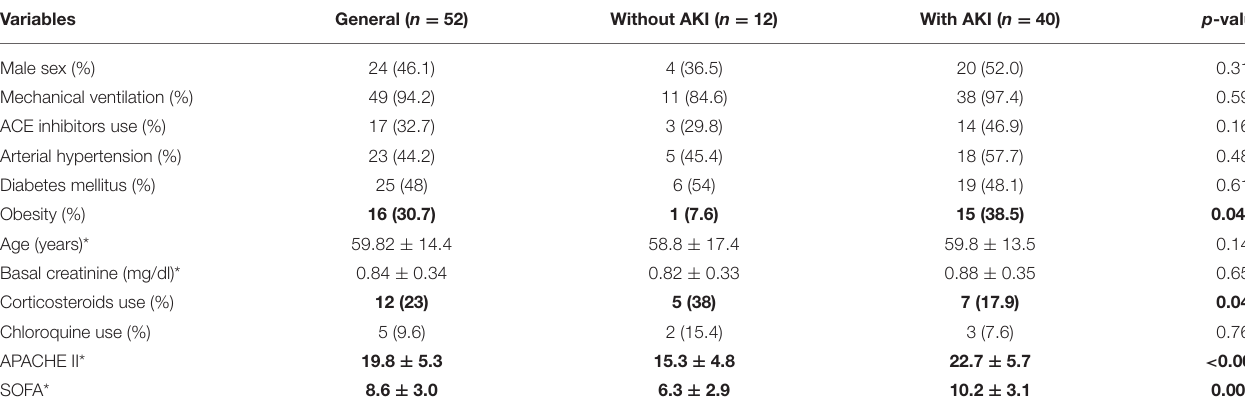
TABLE 4 | Clinical and laboratory characteristics of patients admitted in ICU regarding the presence or absence of AKI.